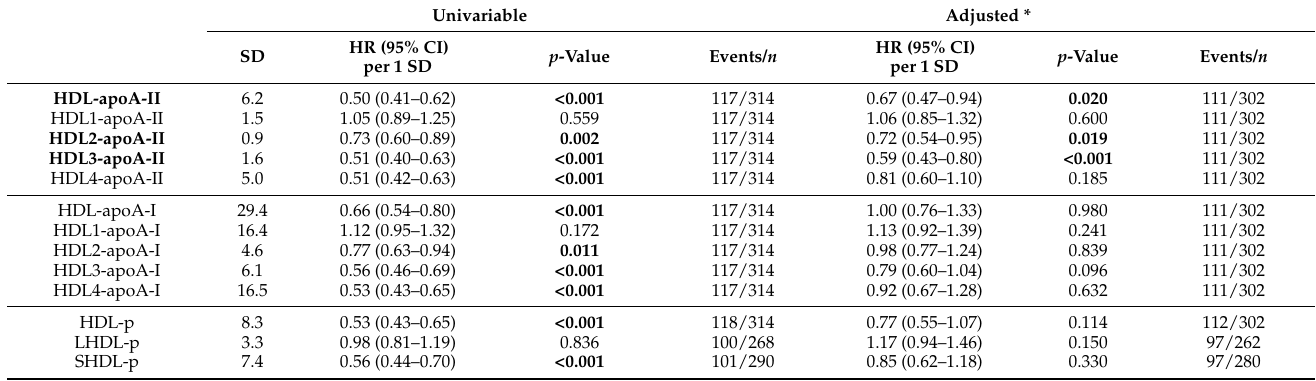
Table 3. Cox regression analyses of HDL parameters as predictors of 1-year mortality in AHF patients.